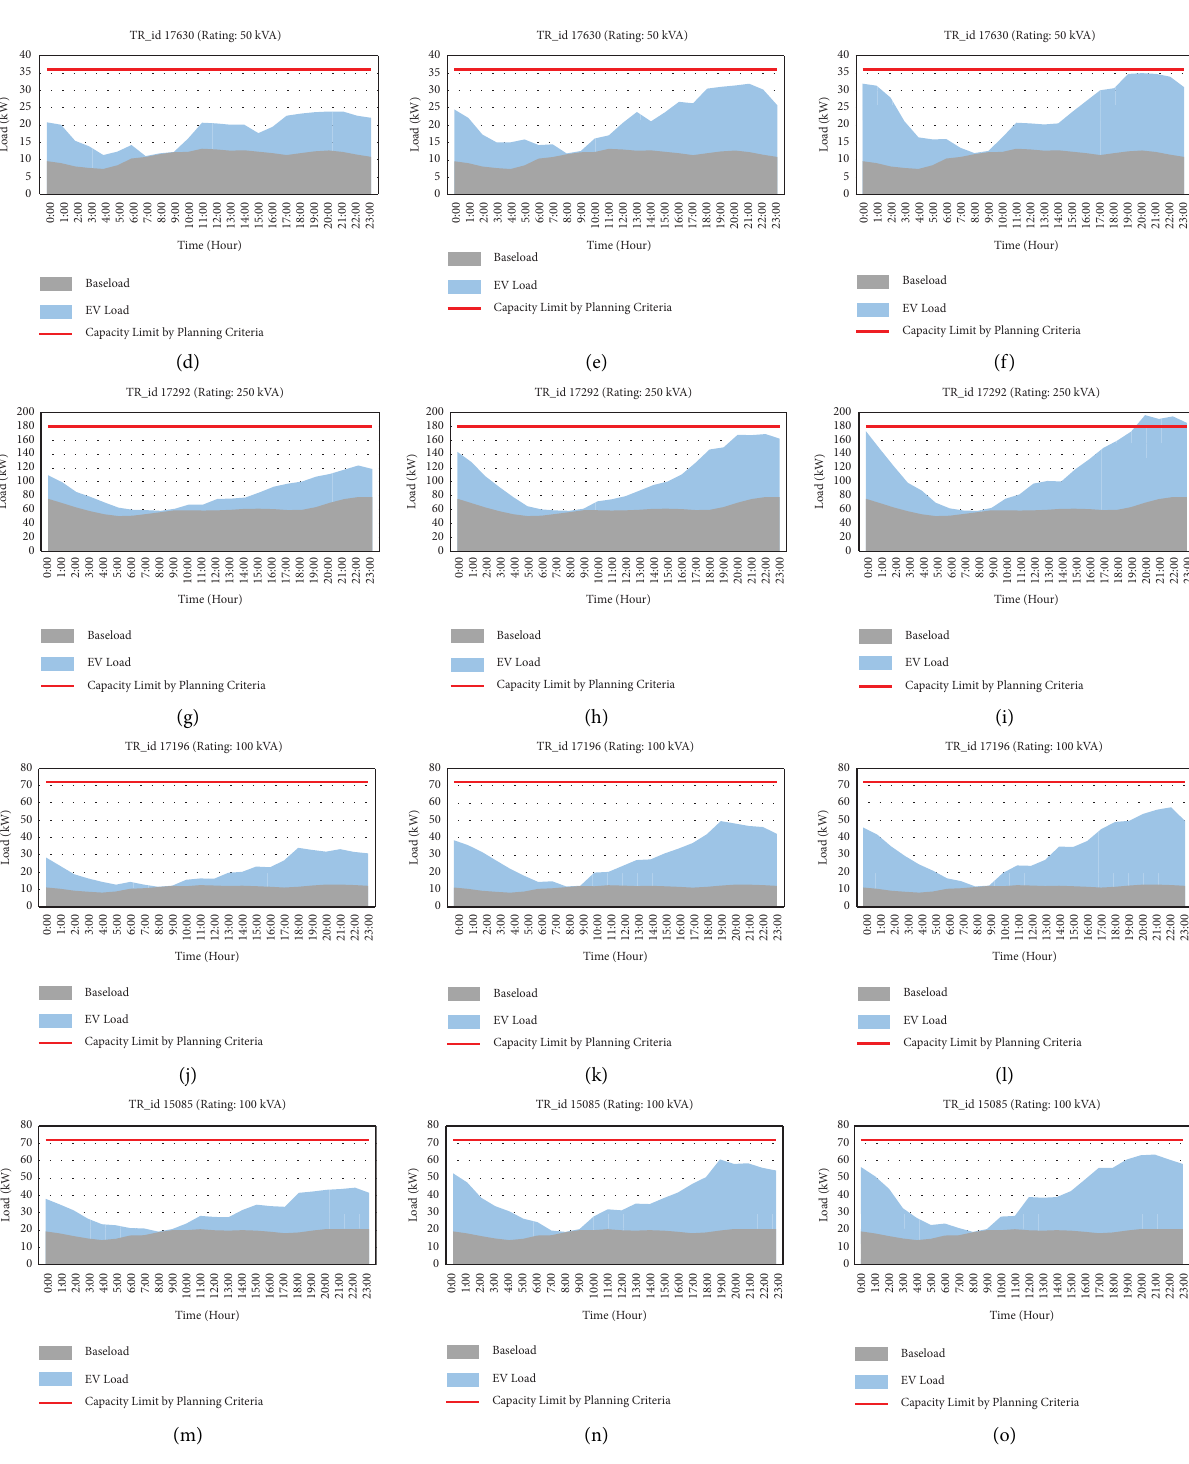
Figure 10: Capacity loading of sampled distribution transformers under fve primary feeders with the three scenarios of EV penetration for uncoordinated charging. Distribution transformer ID 18177 under primary feeder no.1 with (a) 10%, (b) 30%, and (c) 50% EV penetration. Distribution transformer ID 17630 under primary feeder no. 2 with (d) 10%, (e) 30%, and (f) 50% EV penetration. Distribution transformer ID 17292 under primary feeder no. 3 with (g) 10%, (h) 30%, and (i) 50% EV penetration. Distribution transformer ID 17196 under primary feeder no. 4 with (j) 10%, (k) 30%, and (l) 50% EV penetration. Distribution transformer ID 15085 under primary feeder no. 5 with (m) 10%, (n) 30%, and (o) 50% EV